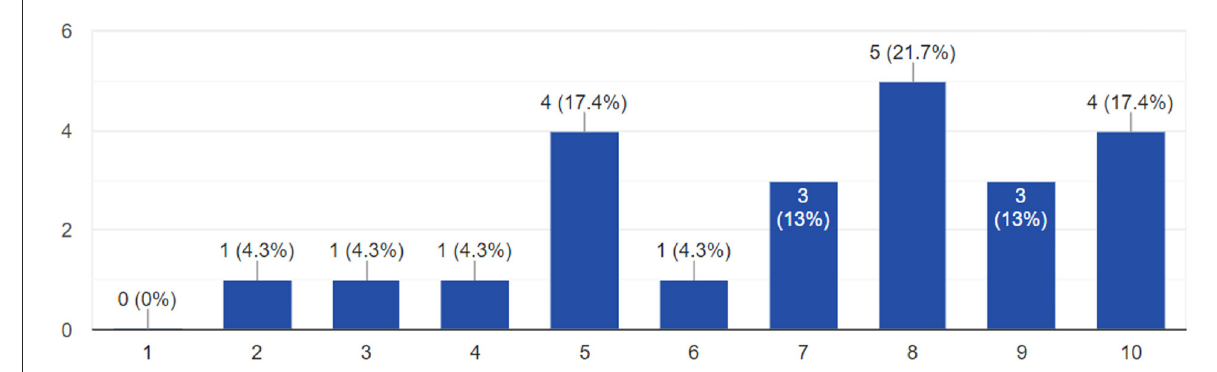
FIGURE12 Public reaction to global econometric loss (1 is less than expected, 10 is more).